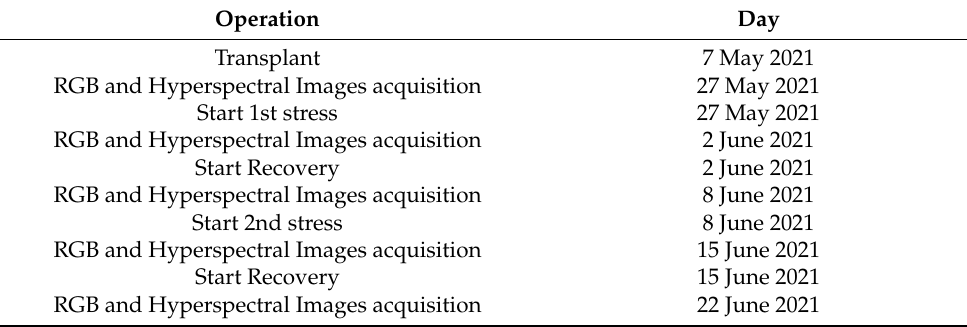
Table 3. Drought stress experiment